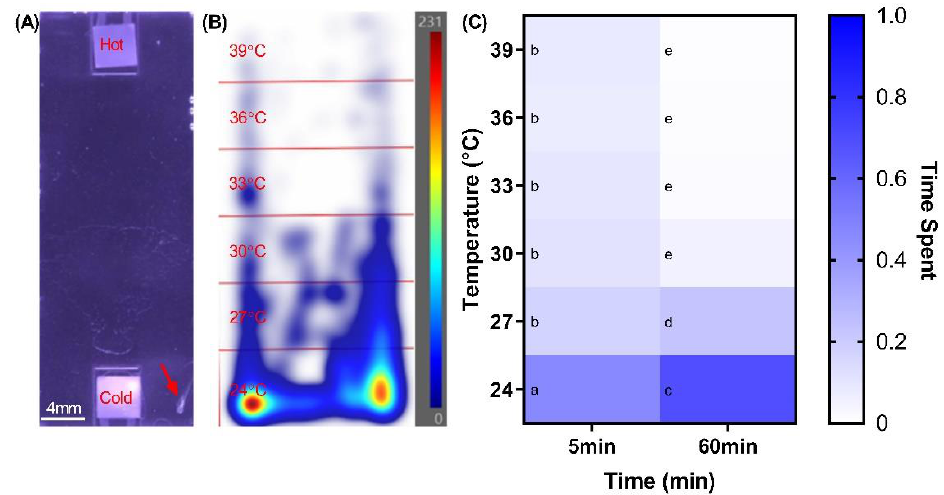
Figure 1. Responses of larval zebrafish to a thermal gradient of 24–39 ◦ C ( A ) Photograph depicting the miniaturized electrothermal array chamber with a zebrafish at 5 dpf, ( B ) An occupancy heatmap of the zebrafish activity highlighting a very strong preference for the 24 ◦ C zone after 60 min of exposure to the thermal gradient ( C ) The thermal preference of zebrafish larvae after 5- and 60-min exposure to the thermal gradient, respectively. Means sharing a letter are not significantly different ( p > 0.05).